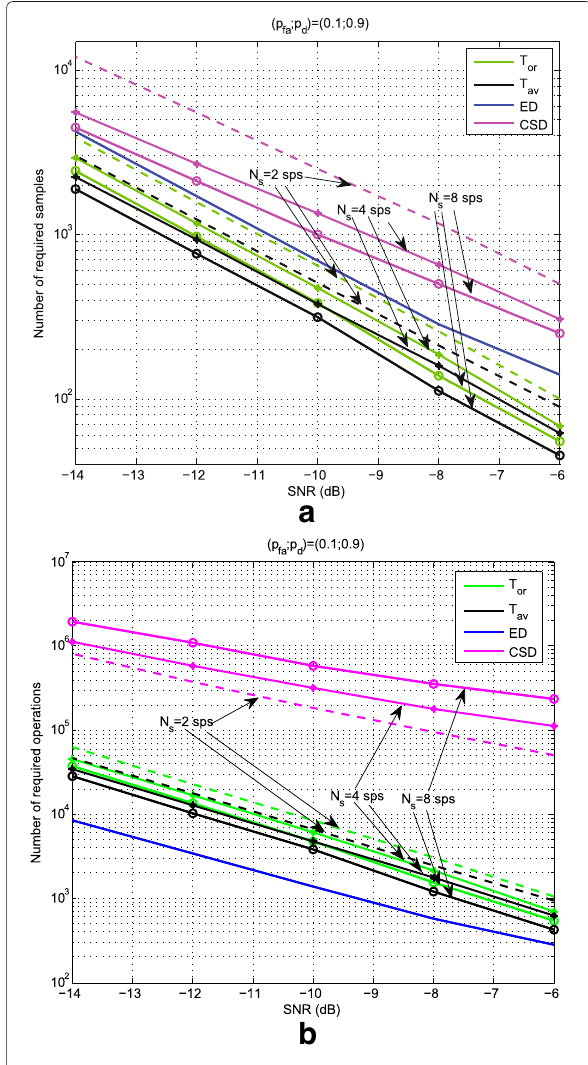
Fig. 8 a The number of samples needed by the detectors in order to reach ( p fa ; p d ) = ( 0.1;0.9 ) for various SNR and b the number of required operations performed by each detectors corresponding to